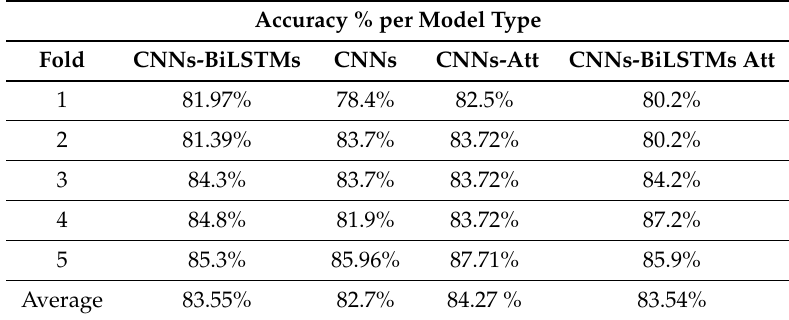
Table 2. Different models Accuracy.